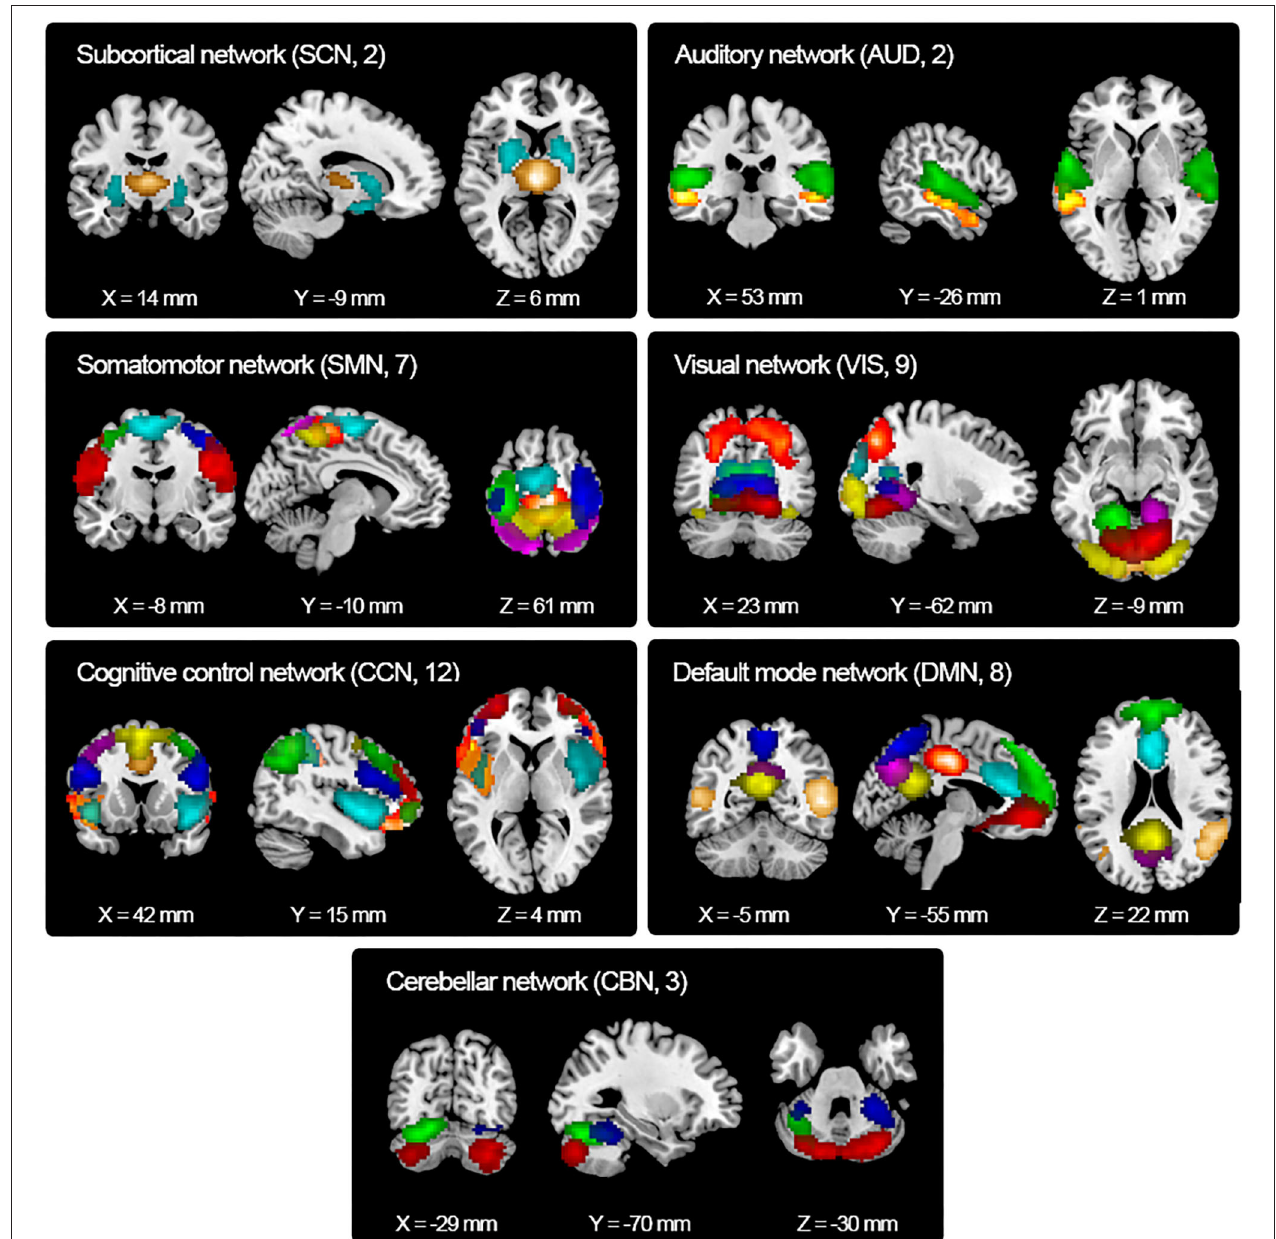
FIGURE 2 | Spatial maps of the identified independent components. Forty-three independent components were identified and sorted into seven functional networks based on their anatomical and functional properties. SCN, subcortical network; AUD, auditory network; SMN, somatomotor network; VIS, visual network; CCN, cognitive control network; DMN, default mode network; CBN, cerebellar